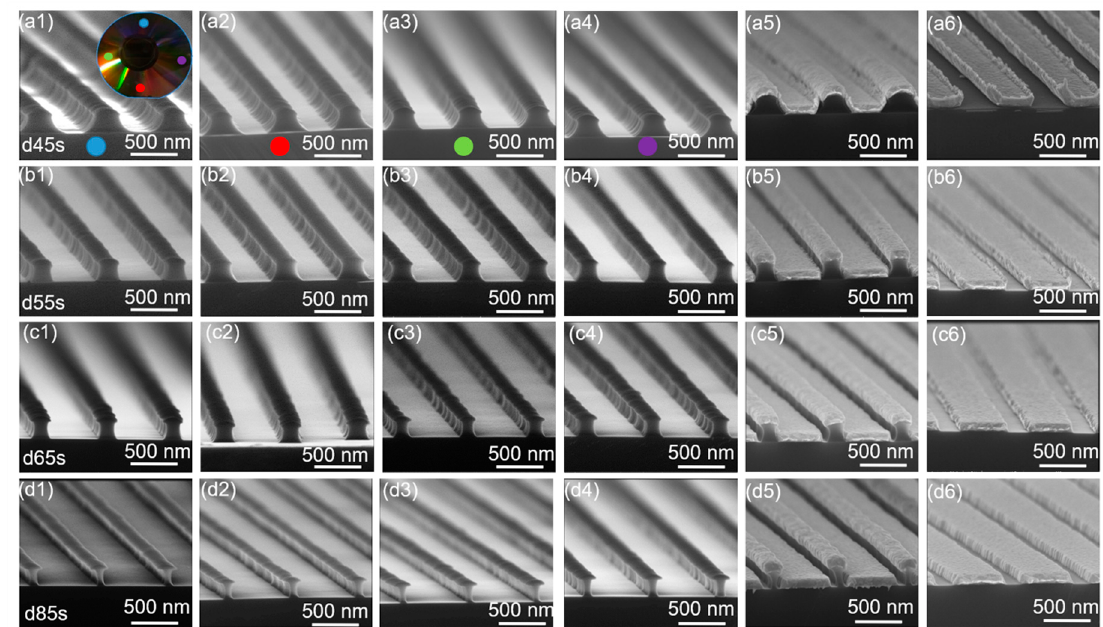
Figure 2. The SEM images of gratings patterned with photoresist under different developing times ( a – d ) in different places marked in the inset of ( a1 ) on the silicon wafer ( 1 – 4 ). ( a5 – d5 ) is the SEM image after Au evaporation of different developing time and ( a6 – d6 ) is the SEM image of gold gratings after lift-off.